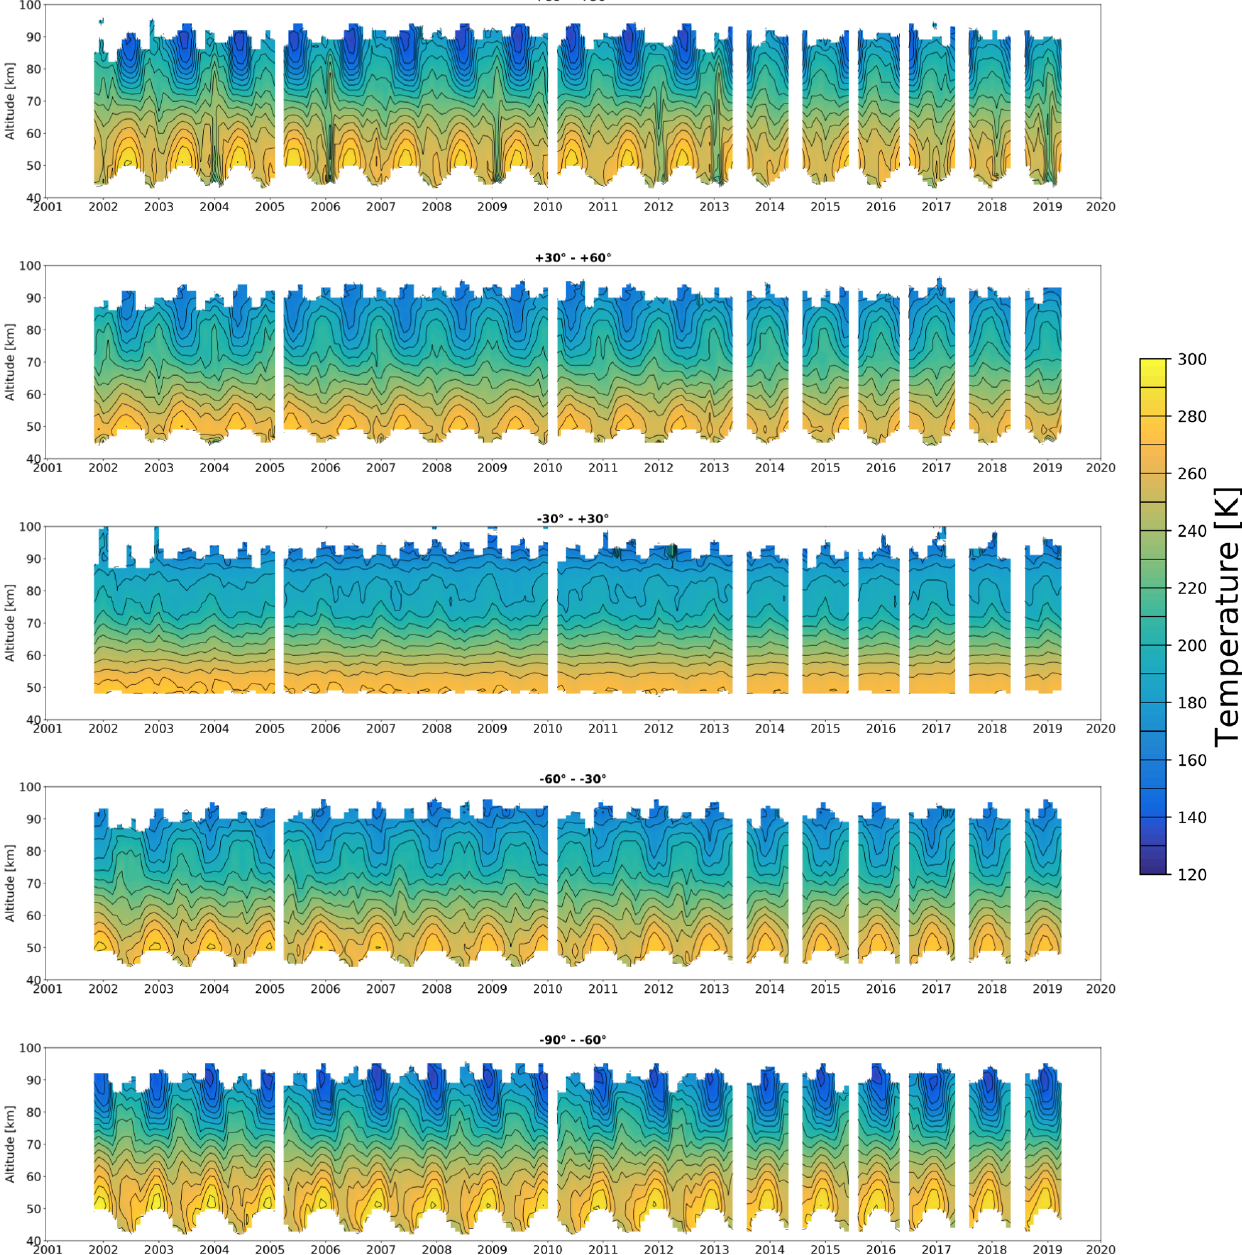
Figure 5. Time series of FM19 temperature measured by SMR for different latitude bands. The white areas indicate periods and altitudes at which the number of measurements in the given latitude band is lower than 10. The ticks on the x axis correspond to the beginning of each